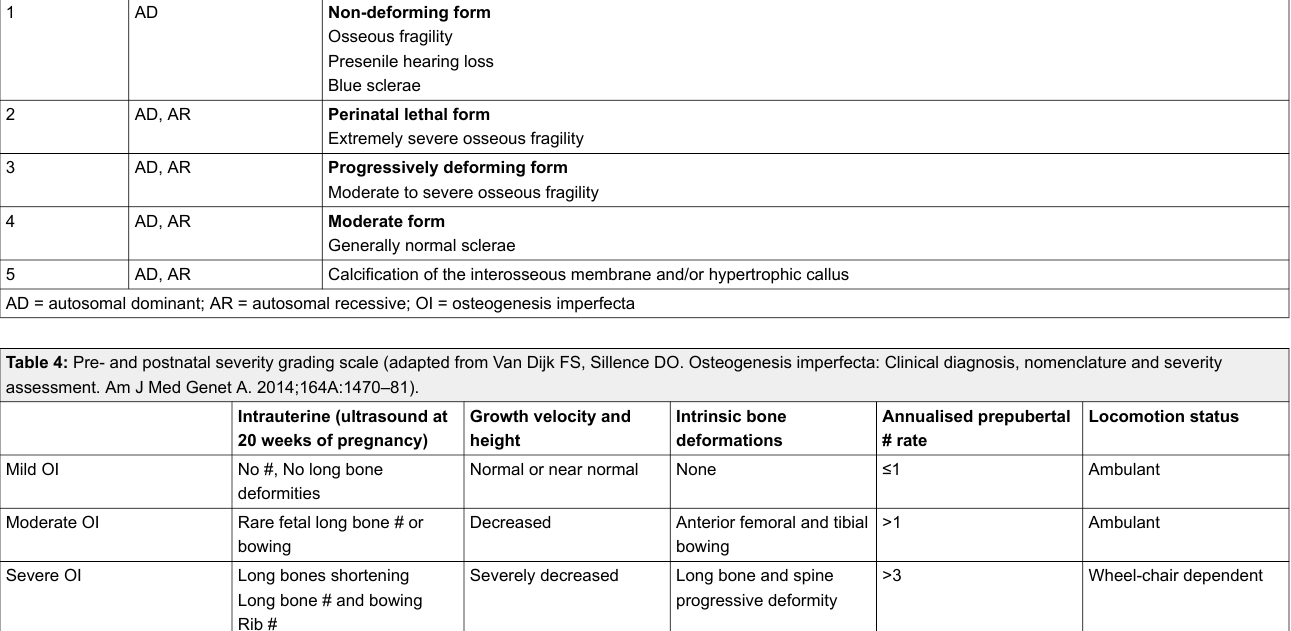
Table 3: Current modified phenotypic Sillence classification of osteogenesis imperfecta from the Nosology Group of the International Skeletal Dysplasia Society (adapted from Bonafé L, et al. Nosology and Classification of Genetic Skeletal disorders: 2015 Revision. Am J Med Genet A. 2015;167A(12):2869-92 9999A:1–24). OI Type